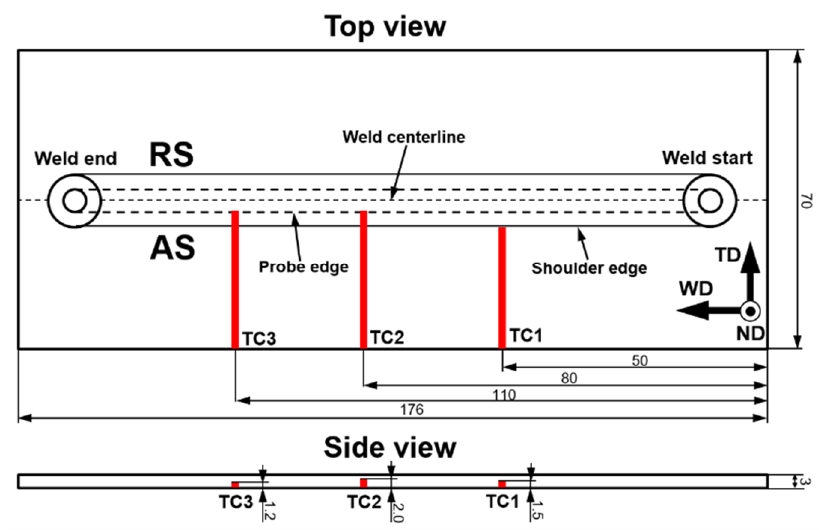
Figure 1. Thermocouples layout inside the workpiece (unit: mm). T1, T2 and T3 show thermocouples used for the temperature measurements in the heat-affected zone, upper section of the stir zone, and bottom section of the stir zone, respectively. WD, the ND and TD refer to welding direction, normal direction and transverse direction, respectively; AS and RS refer to advancing side and retreating side, respectively. Not in scale.